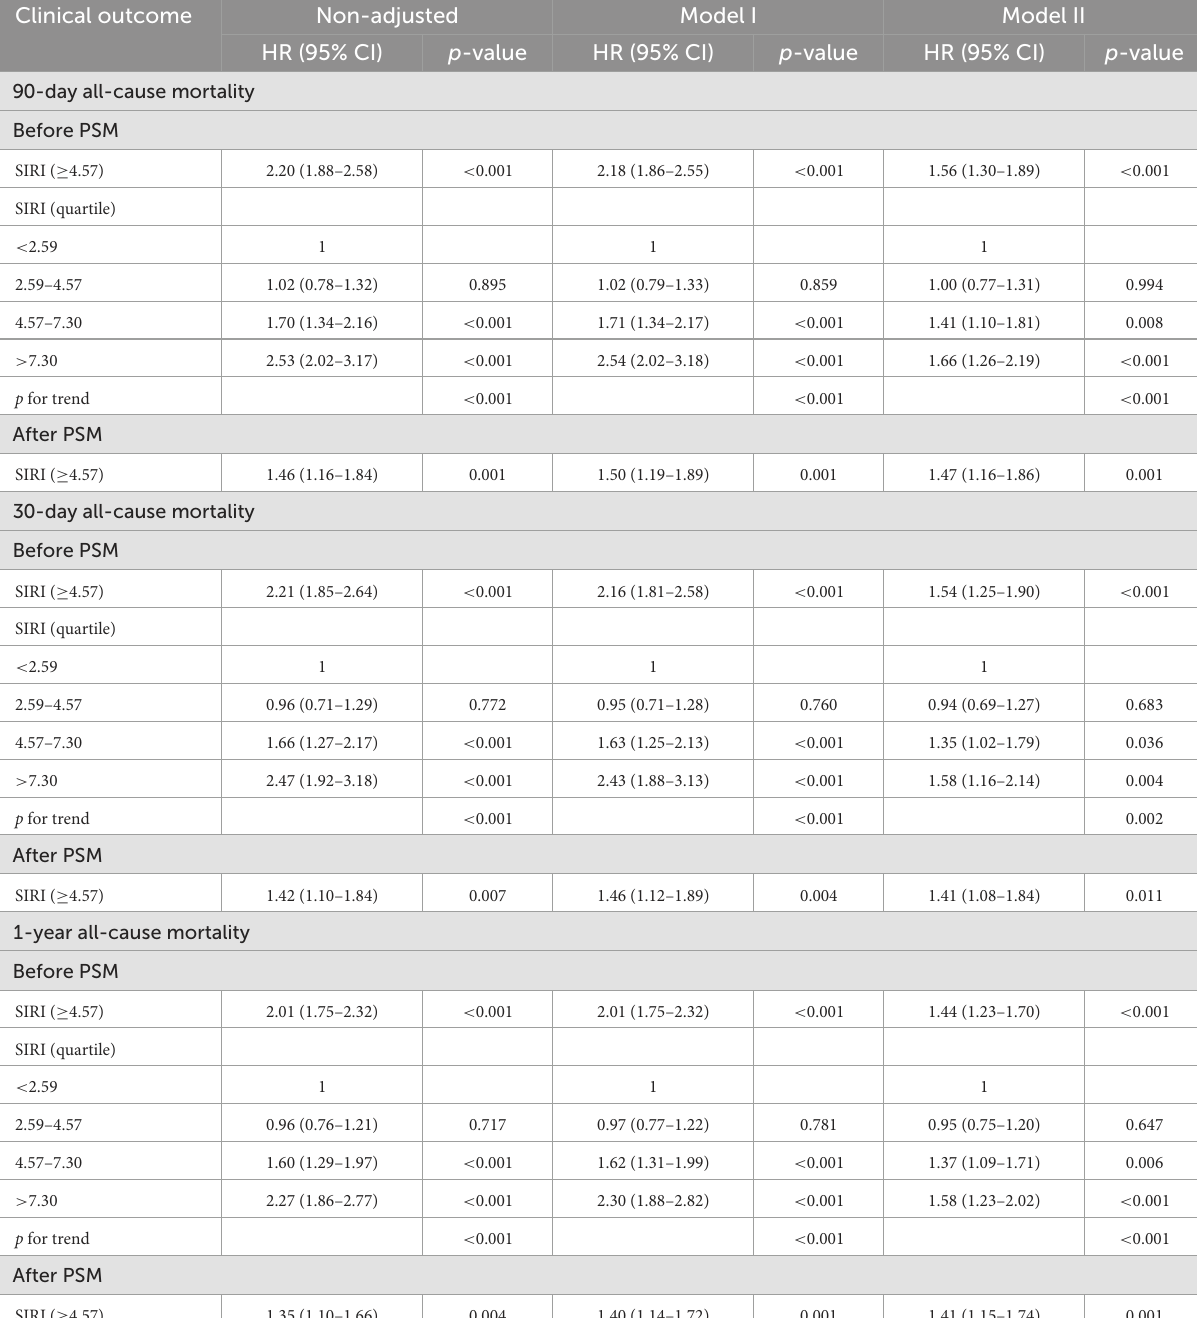
TABLE 2 Univariate and multivariate Cox regression models used to study the association of SIRI with mortality in patients with AIS. Clinical